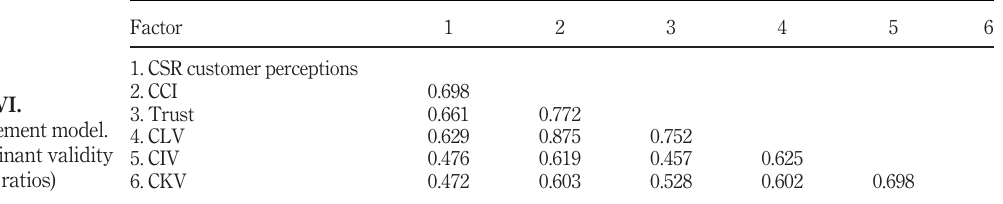
Table VI. Measurement